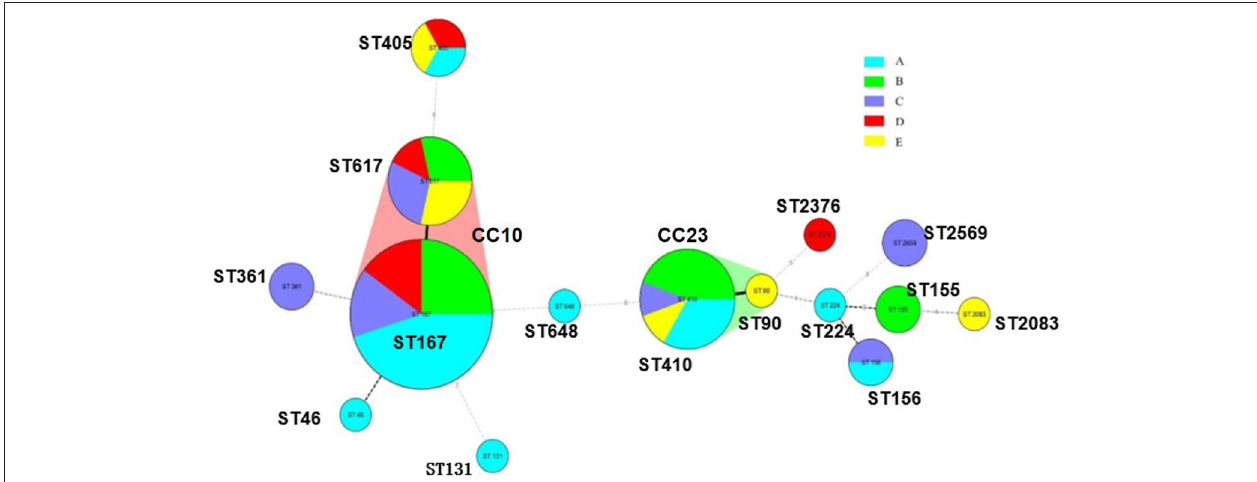
FIGURE 2 | Minimum spanning tree of 54 CRECO isolates from different